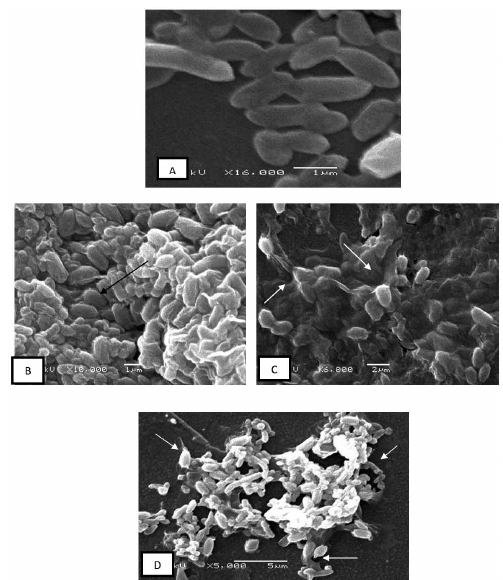
Fig 4. Microphotographs of Bacillus subtilis cells (treated/control) with ethanol extracts of fruit pulp with seeds Scanning electron microscopy of B. subtilis A- control cells, non-treated cells with well-defined margins B and C – Treated cells show clumping and aggregation of cells. D-Leaked cells with blebs and protrusion, completely distorted and damaged cells can be